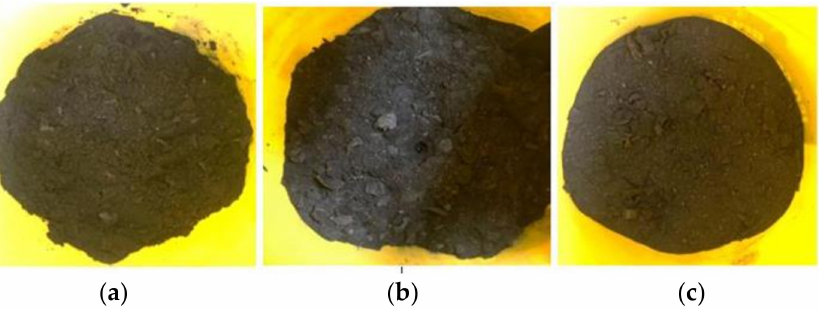
Figure 10. Soil samples after 21 days of soil composting. ( a ) Soil Sample 1 (Bokashi A1); ( b ) Soil Sample 2 (Bokashi A2); ( c ) Soil Sample 3 (Bokashi